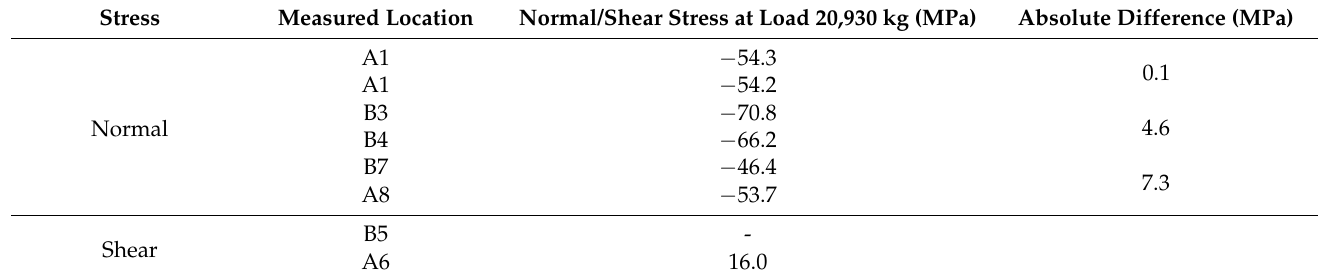
Table 4. Maximum stress values measured when handling steel coil 6 in Mode